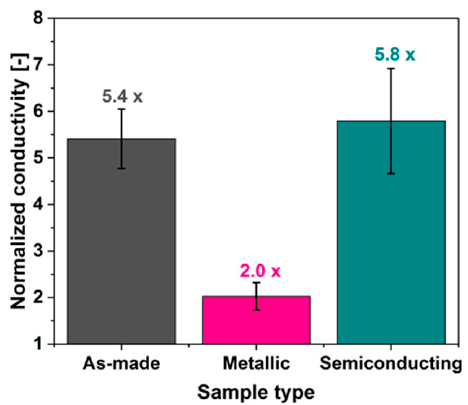
Figure 9. The influence of BF 3 on the electrical conductivity of unsorted and sorted CNT films.